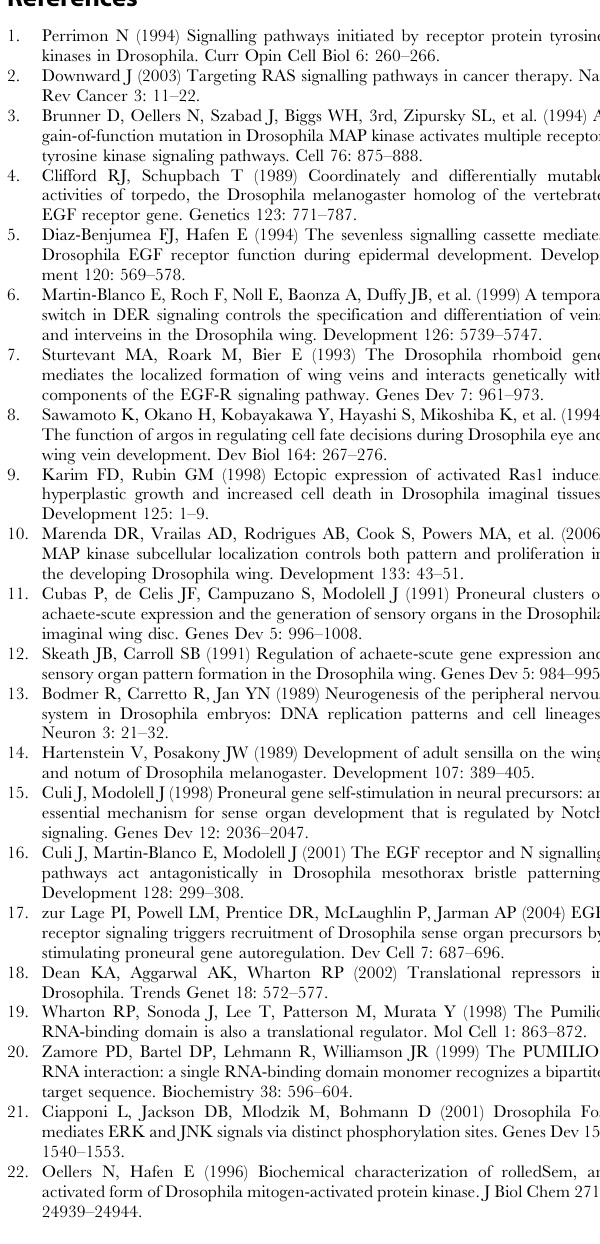
Figure S1 Reduction of EGFR signaling causes loss of wing veins. Wing veins are lost by the reduction of